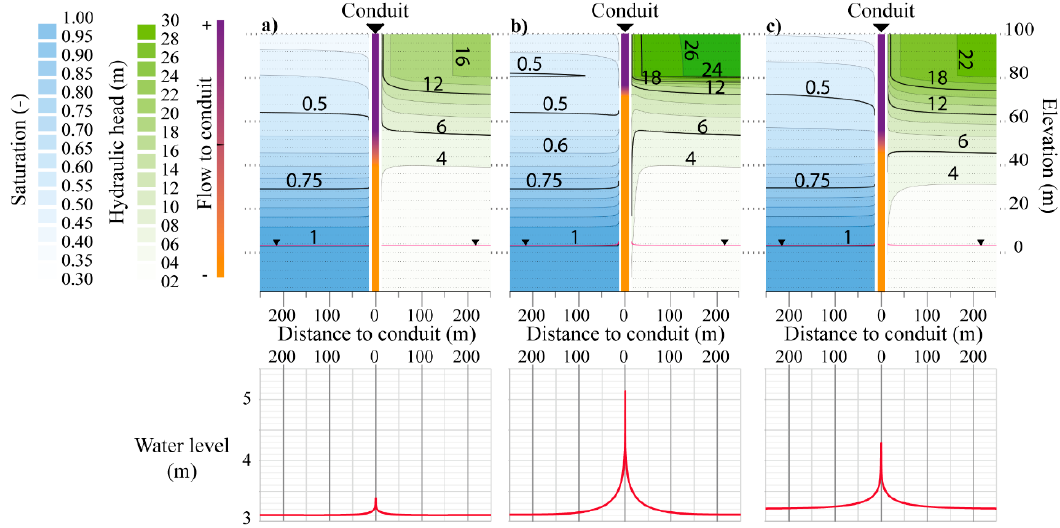
Figure 2. Profiles of the saturation (blue) and hydraulic head (green) around the conduit, with plots zooming on the water level at three time steps: ( a ) at steady state before the recharge event, ( b ) at the end of the recharge event, ( c ) 77 days after the event.